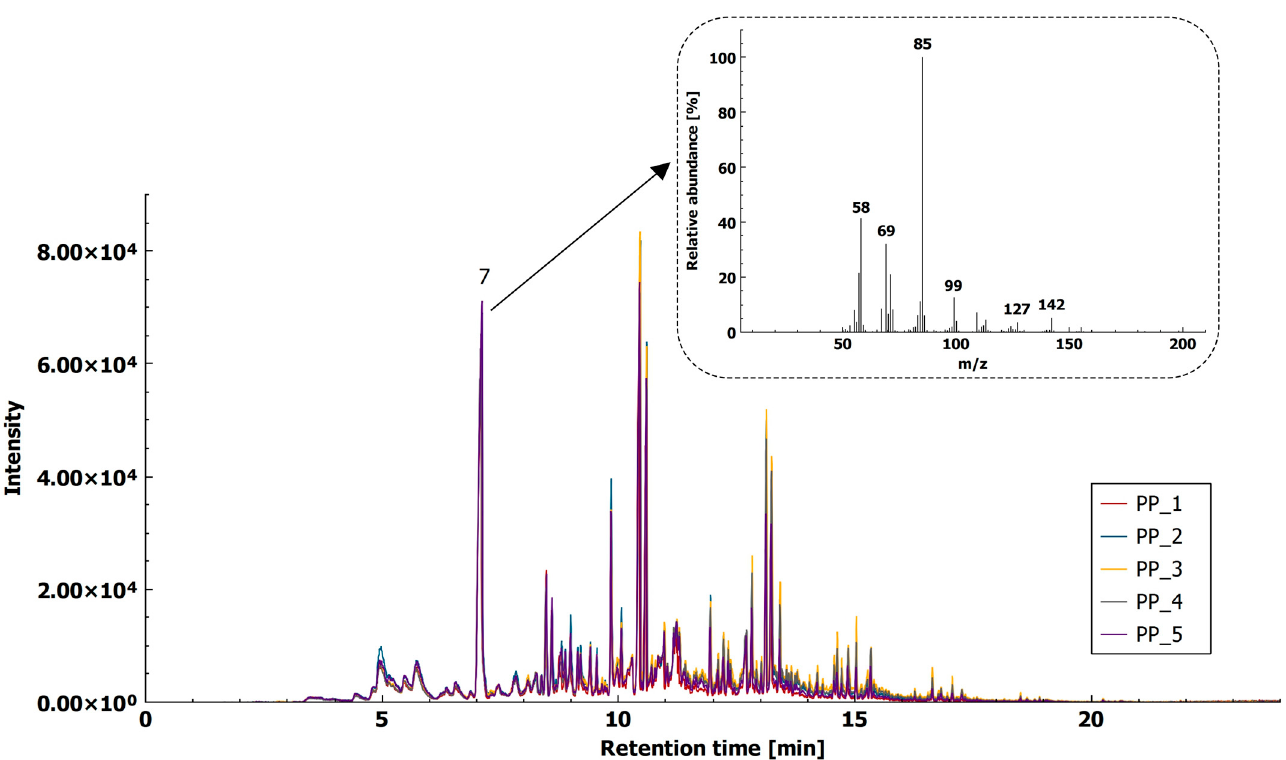
Figure 4. HS-SPME-GC–MS extracted ion chromatogram (XIC, m / z 142) of PP (5 replicates) with mass spectra for 4,6-dimethyl 2-heptanone (7).